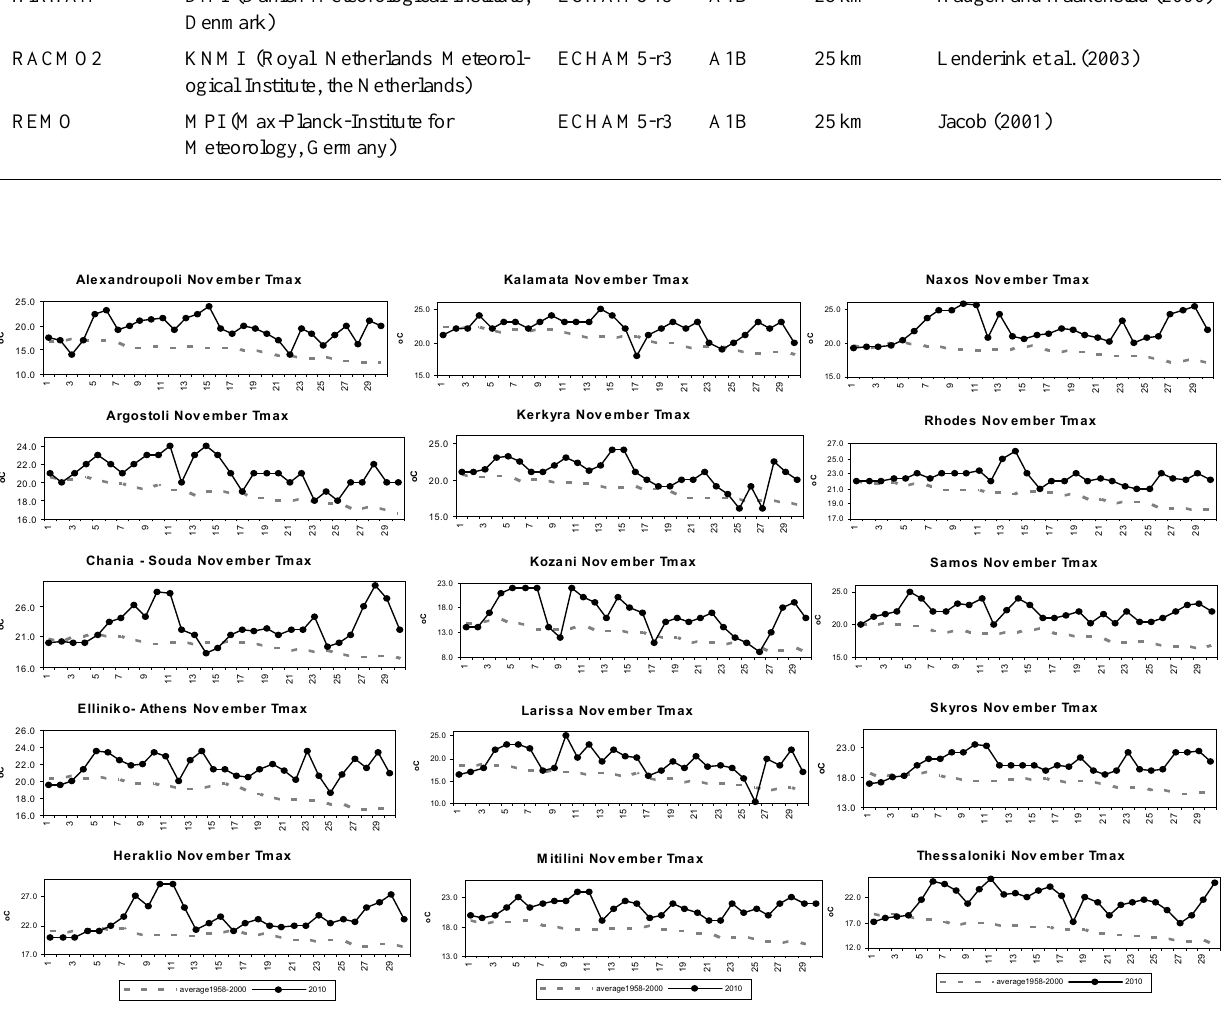
Figure2 . Daily maximum temperature time-series for the 15 stations under study, for November 2010 and for the mean November long term period 1958-2000.